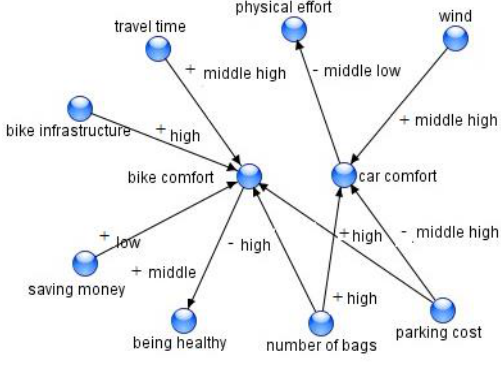
Fig. 3. Example of an